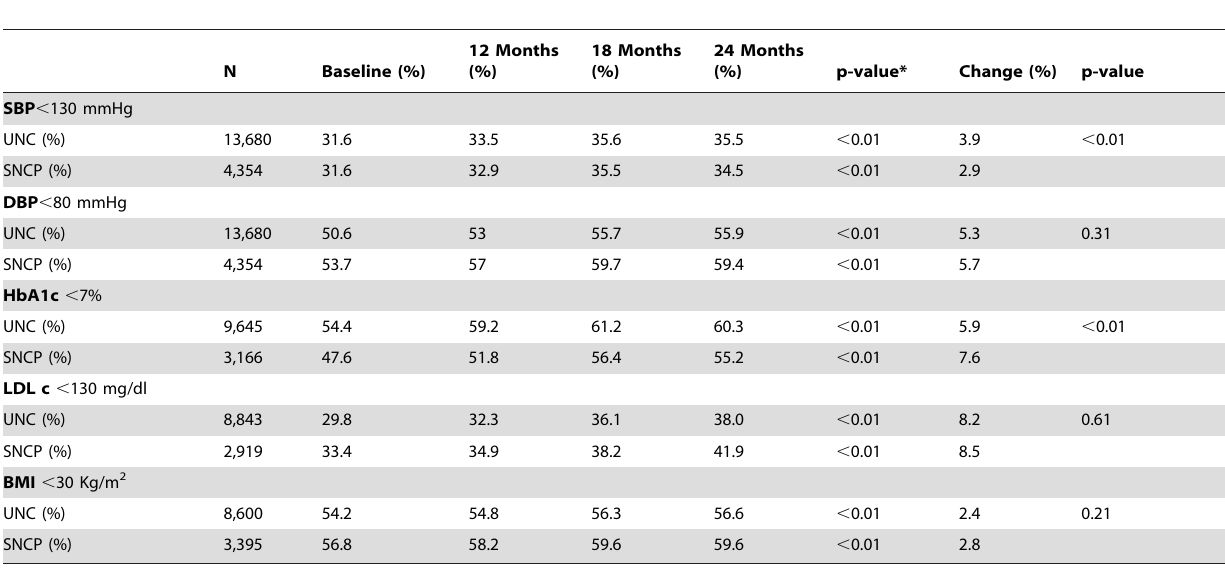
Table 5. Percentage of subjects on-target for cardiovascular risk factors at baseline and at the two-year follow-up, stratified by group (UNC/SNCP).